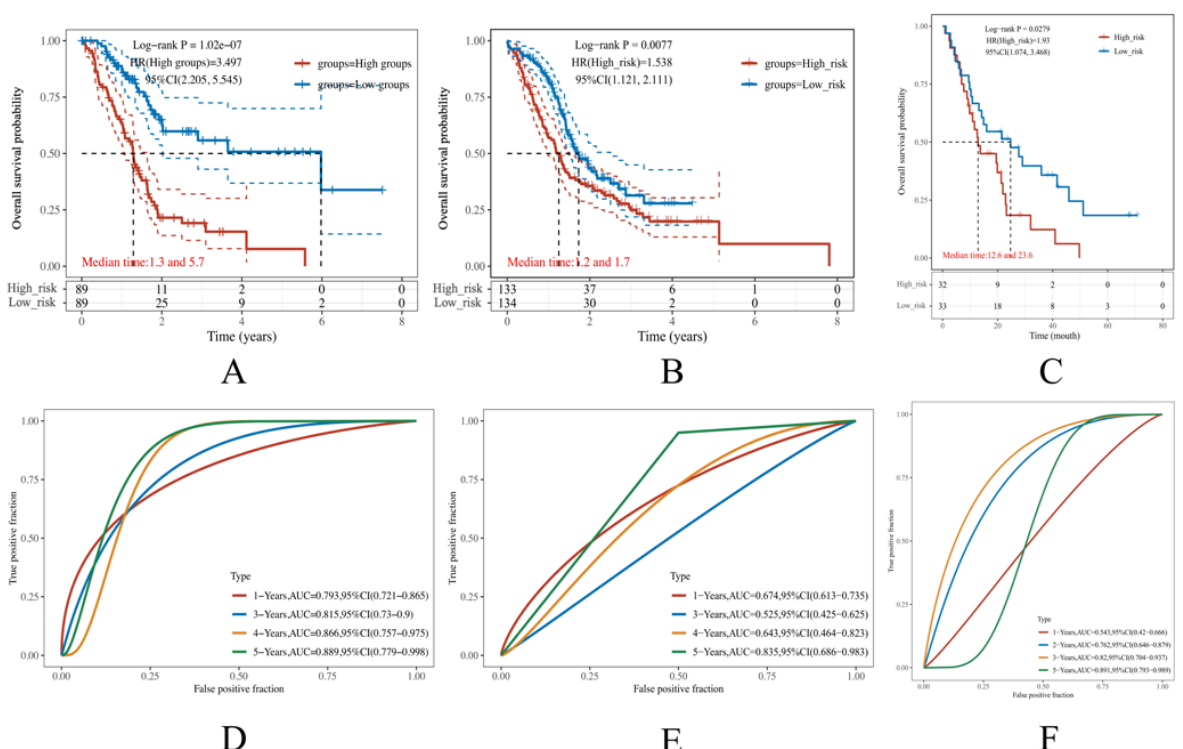
Figure 3. Construction of the immune-related gene prognostic index (IRGPI)-based risk model. ( A – C ) The Kaplan Meier (KM) curves demonstrate the overall survival (OS) rate of PAAD patients in the TCGA, ICGC, and GEO datasets, respectively. ( D – F ) The time-dependent receiver operative characteristics (ROC) curves of our risk model performed in the TCGA, ICGC, and GEO datasets, respectively. The larger the area under the curve (AUC), the more reliable the model.